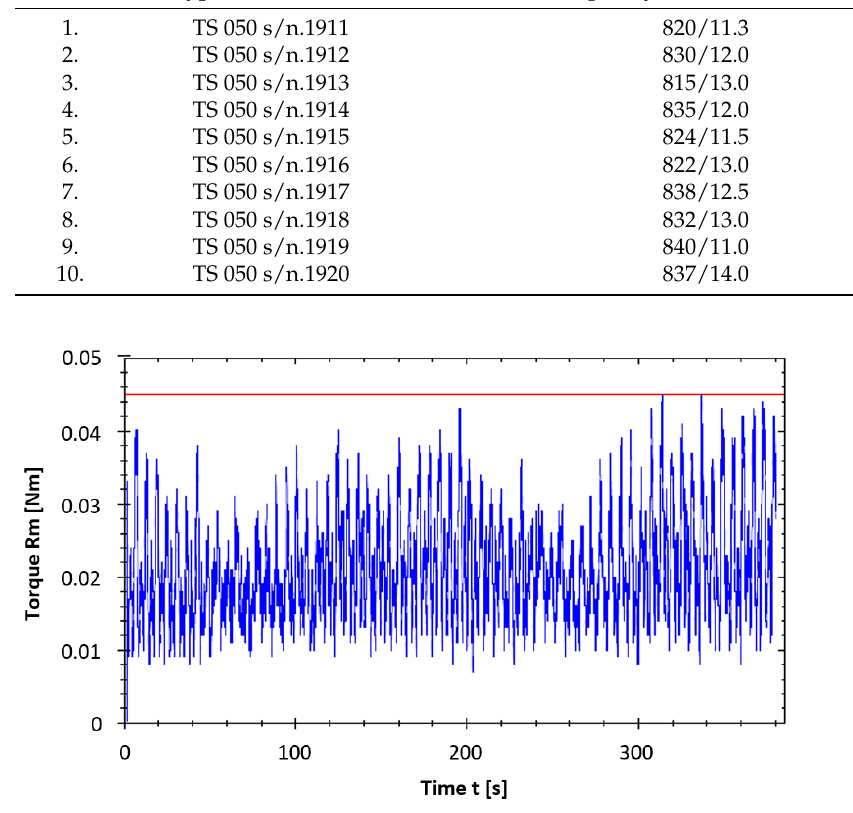
Figure 15. Starting torque (Rm) BR TS 050-63, s/n.1911—CW direction (before the trial run).